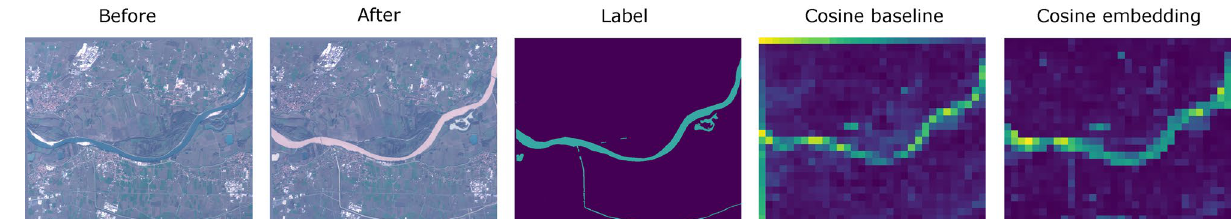
Figure 4. Comparison of the change detected using the baseline and the large VAE method on an example of a flooding river. Two images immediately before and immediately after a change are shown, along with the human labels of change and the calculated change scores. Both methods used a history of k = 3 frames.